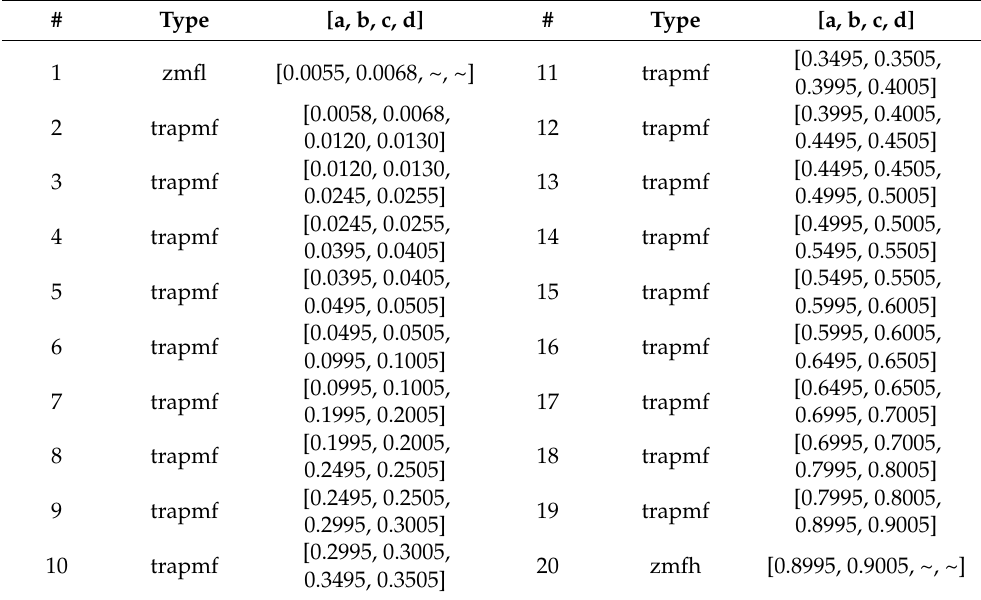
Table 2. Fuzzy-sets and their membership